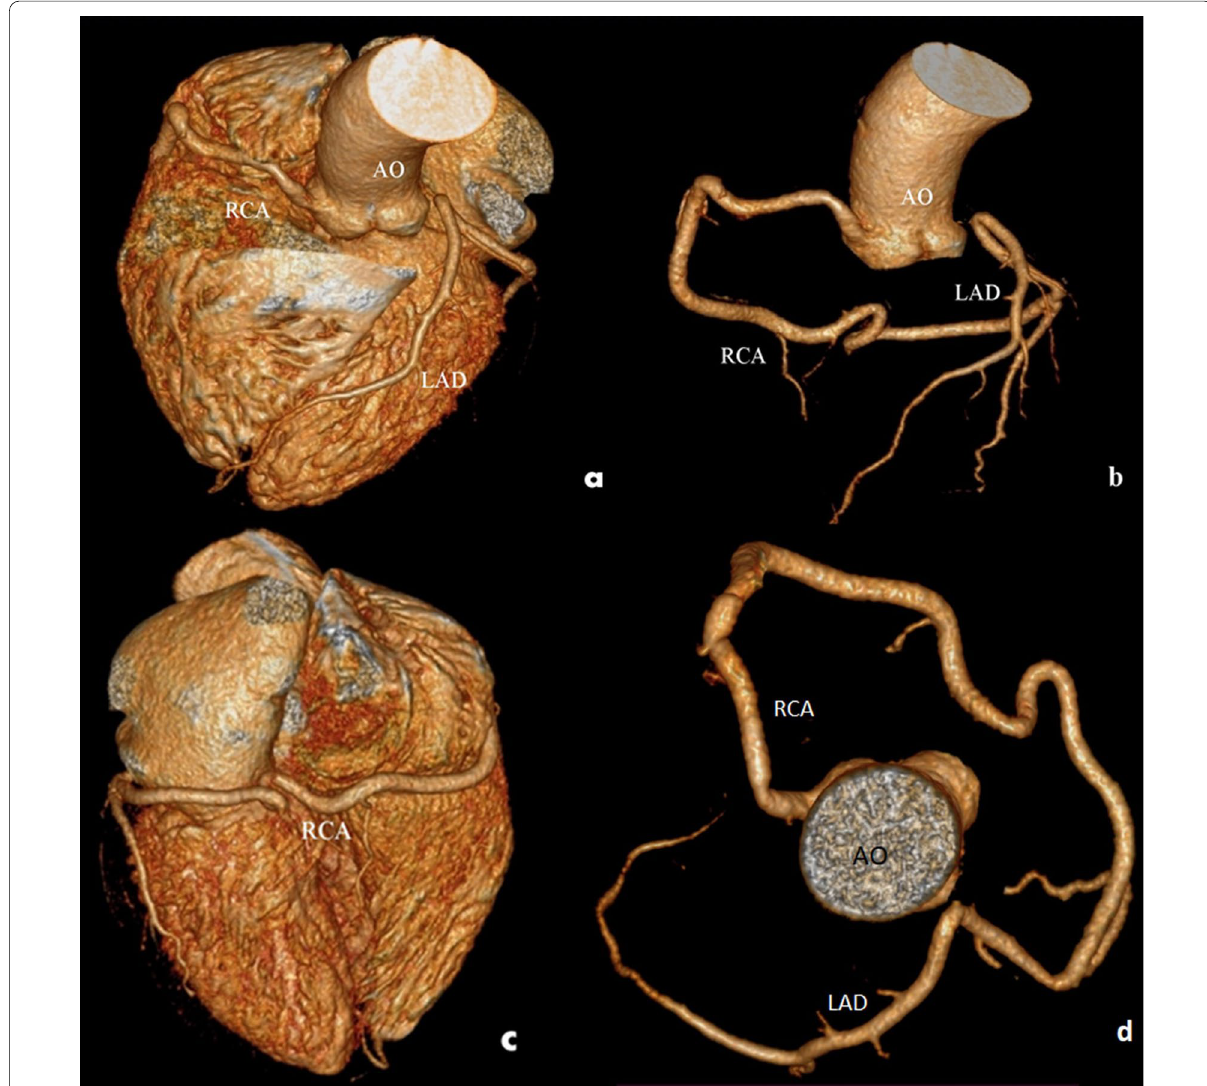
Fig. 2 A 50-year-old man with an isolated anomaly of a single right coronary artery: CTA volume rendered ( a–d ) images showing coronary arterial tree with isolated R-I type of single right coronary artery (RCA) arising from right Aortic (AO) sinus. It was traversing the right atrio-ventricular groove, coursing through the crux of the heart and then reaching the left atrio-ventricular groove and continuing as left anterior descending artery